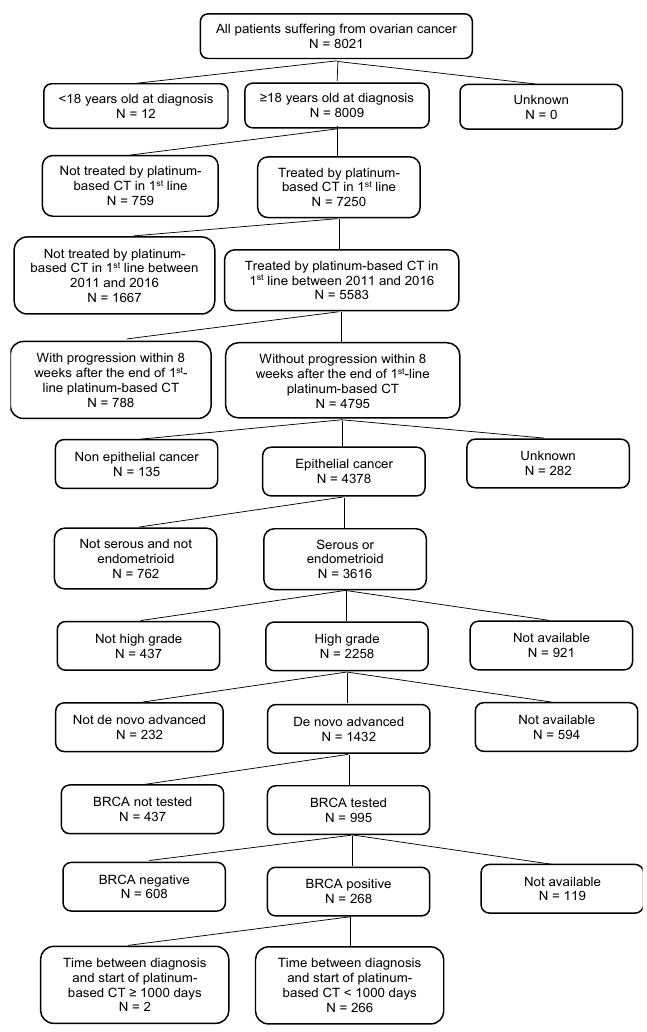
Figure A1. Figure A1.